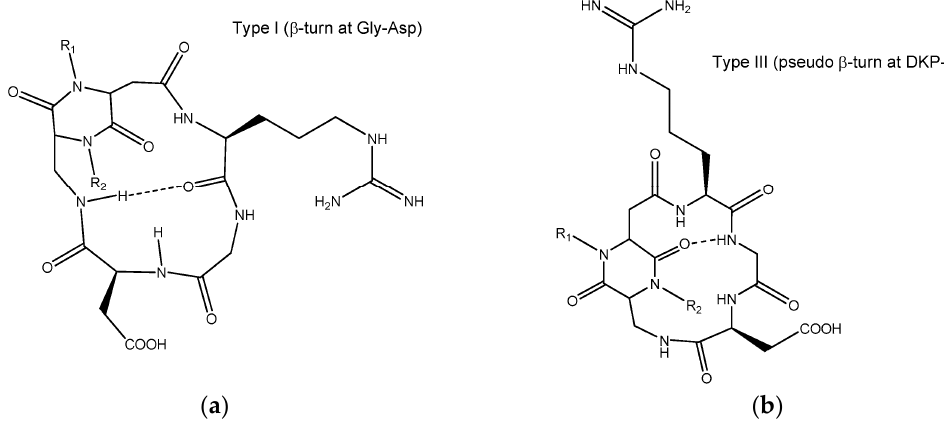
Figure A1. ( a ) 2D representation of type I geometry; ( b ) 2D representation of type III